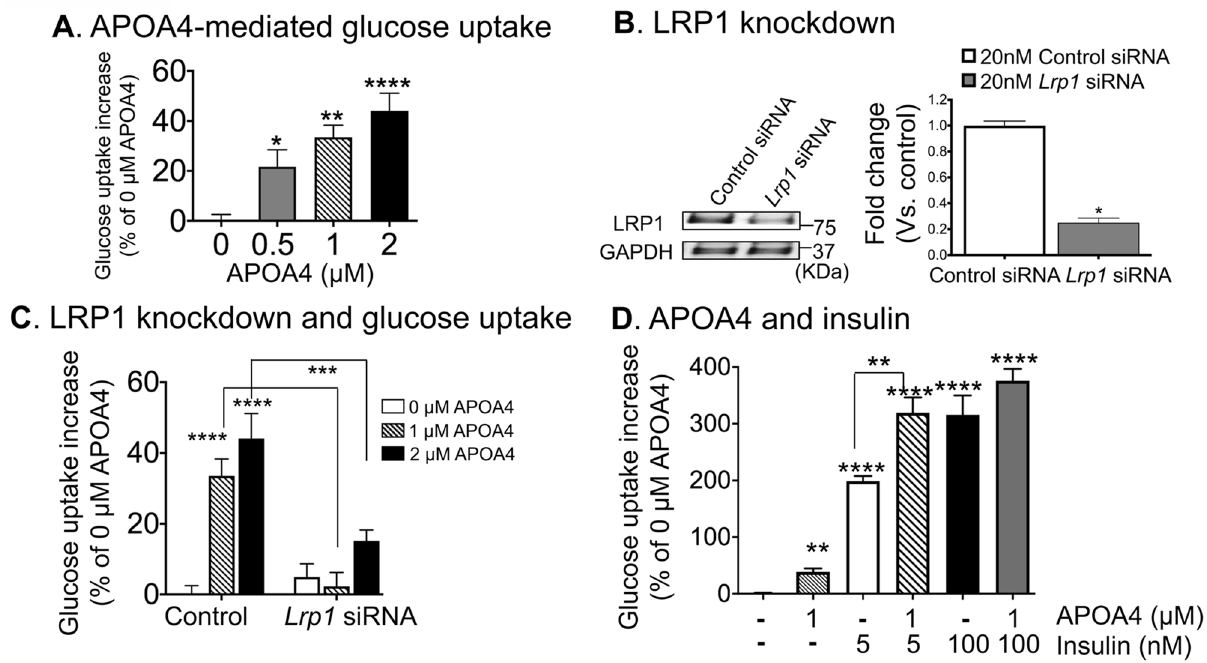
Figure 4. APOA4-stimulated glucose uptake was mediated by LRP1 in 3T3-L1 mature adipocytes. ( A ) APOA4 stimulated glucose uptake by 22–44% in a dose-dependent manner. 3T3-L1 mature adipocytes were incubated with 0, 1, and 2 μM r-m-APOA4 for 1 h (n = 5 per treatment). ( B ) SiRNA targeting Lrp1 gene was transfected into 3T3-L1 mature adipocytes. Left, a representative western blot image showing reduced LRP1 levels in Lrp1 siRNA-treated cells, compared to control siRNA-treated cells. GAPDH was used as internal control. Right, quantification of the band intensity revealed ~ 75% decrease in average band intensity for LRP1 protein in Lrp1 siRNA compared to control siRNA. *p < 0.05, Student’s t -test. ( C ) Lrp1 knockdown abrogated 1 µM and 2 µM APOA4-stimulated glucose uptake by ~ 93% and 67%, respectively, compared with 1 and 2 µM controls. Data are presented as percentage increase of basal glucose uptake levels under control siRNA treatment. (D) Insulin- stimulated glucose uptake increased in adipocytes at 5 nM and 100 nM versus untreated. APOA4 (1 µM) treatment further augmented insulin-stimulated glucose uptake at 5 nM, suggesting they act synergistically to promote glucose uptake. Two-way analysis of variance (ANOVA) revealed significant main effects of Apo- A-IV concentration ( p < 0.0001) and siRNA treatment ( p < 0.0001) as well as interaction between treatments (p = 0.0007). Sidak’s multiple comparisons test revealed statistically significant changes. **** p < 0.0001, 0 µM vs. 1 and 2 µM (Control), and *** p < 0.001, 1 µM and 2 µM control vs. 1 µM and 2 µM Lrp1 siRNA, respectively (n =